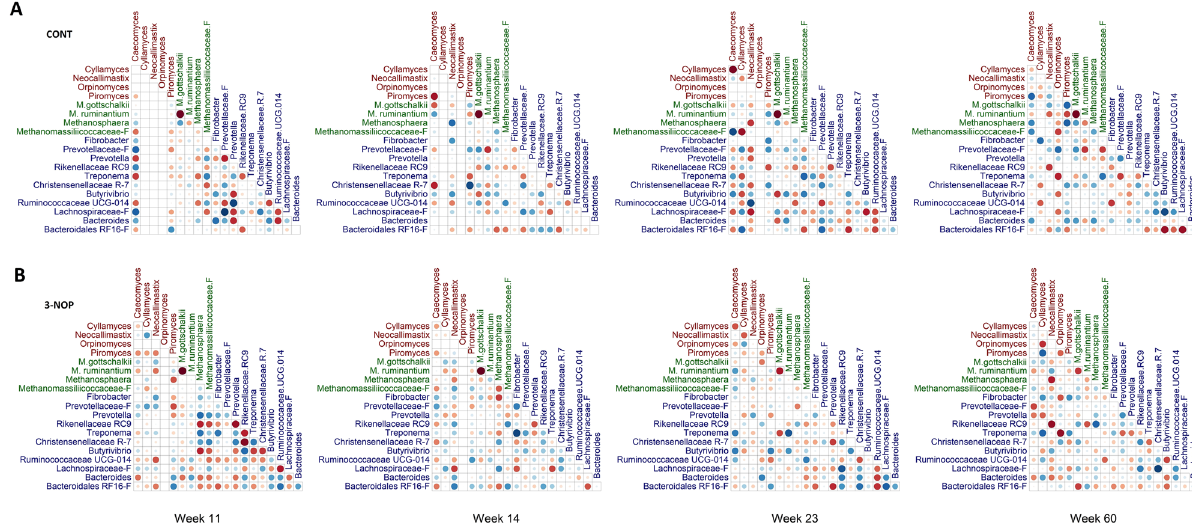
Figure 4. Co-occurrence of ruminal genera differed in CONT versus 3-NOP calves at different ages. Circles represent relationships (positive, blue circles; negative, red circles) between taxa abundance in CONT ( A ) and 3-NOP ( B ) calves, determined using a Spearman non-parametric rank correlation matrix. Larger circles represent stronger correlations. Anaerobic fungi are displayed in red, archaeal taxa in green, and bacteria in